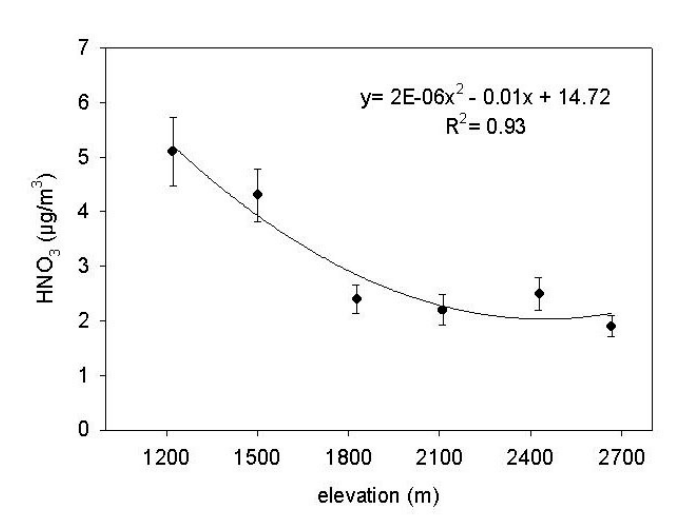
FIGURE 8. Changes of seasonal means of HNO 3 (µg m -3 ) along the elevation gradient in the San Bernardino Mountains. Means ±